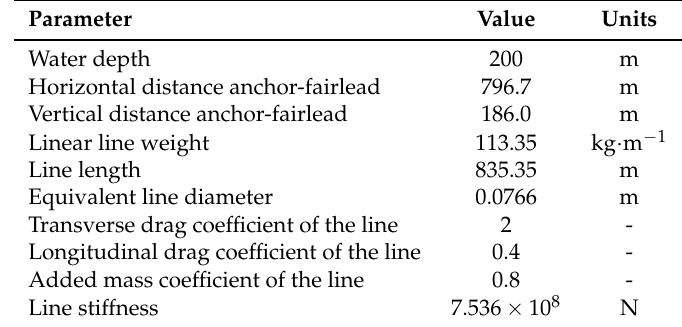
Table 2. Main characteristics of the 5 MW NREL mooring system implemented in